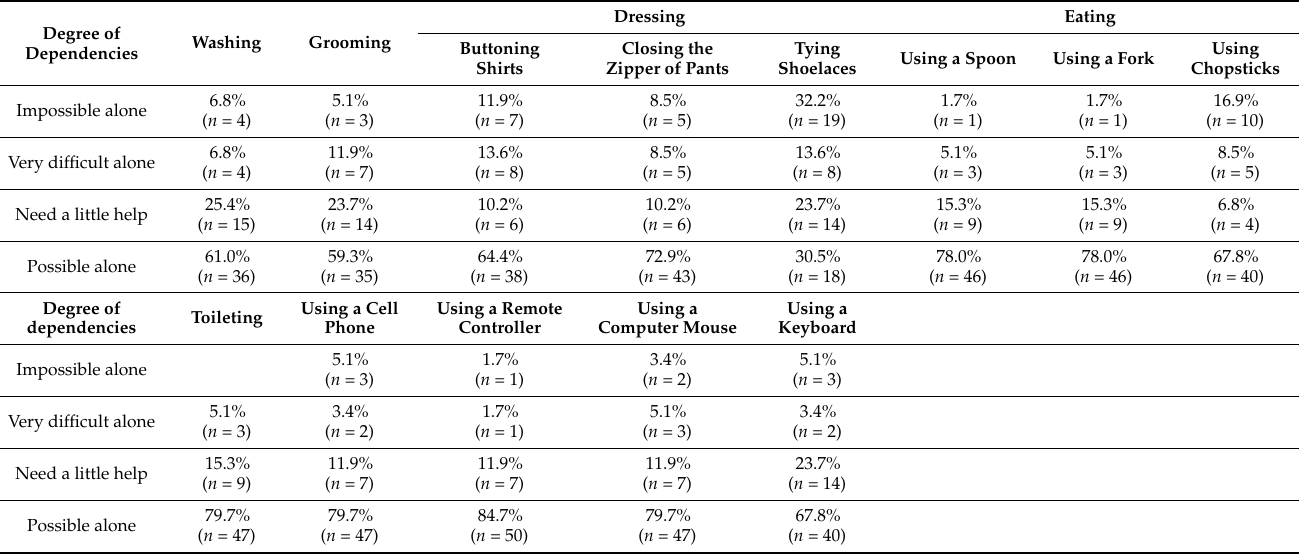
Table 8. ADL performance assessment of upper-limb amputees ( n = 59).